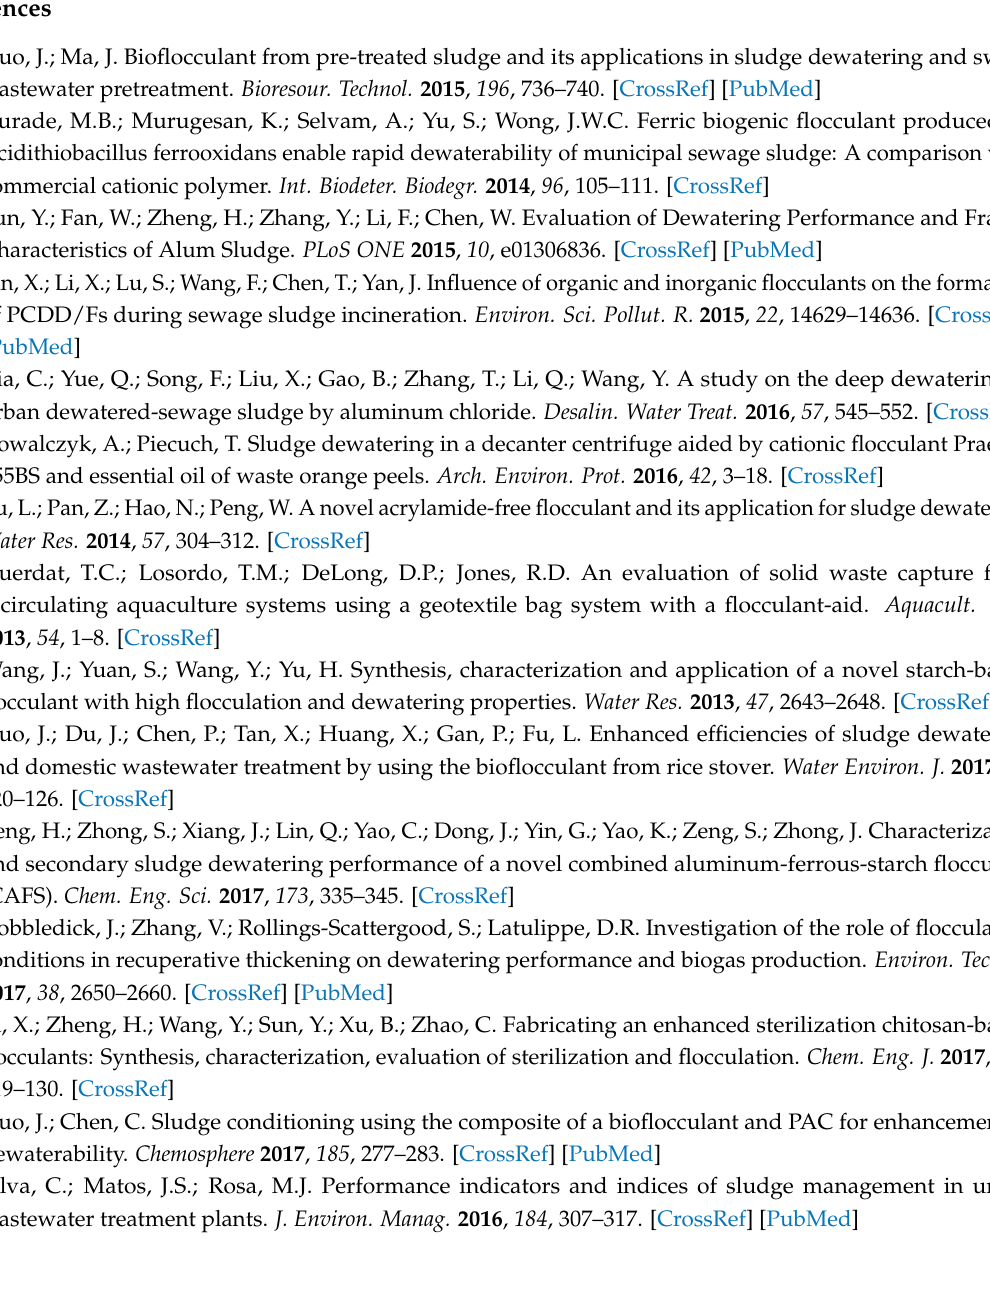
CCPAD: (a) intrinsic viscosity and (b) grafting ratio and grafting efficiency; Figure S4. Effect of photo-initiator concentration on the synthesis of CCPAD: (a) intrinsic viscosity and (b) grafting ratio and grafting efficiency; Figure S5. Effect of pH on the synthesis of CCPAD: (a) intrinsic viscosity and (b) grafting ratio and grafting efficiency; Figure S6. Effect of illumination time on the synthesis of CCPAD: (a) intrinsic viscosity and (b) grafting ratio and grafting